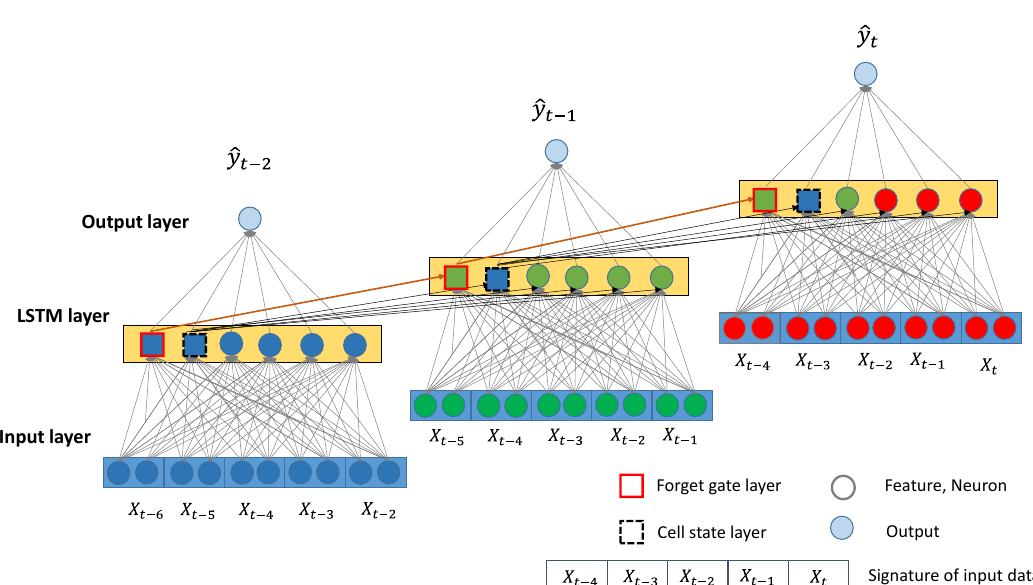
Figure 3. Design of LSTM for signature data from CAPs.